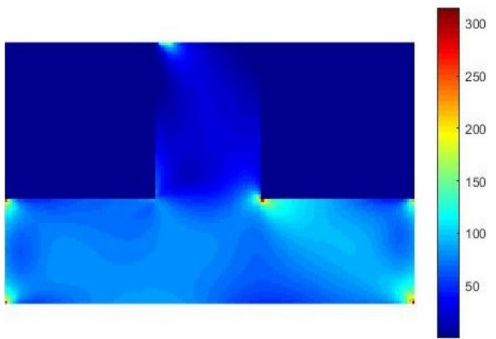
Figure 13. Initial structural stress distribution.